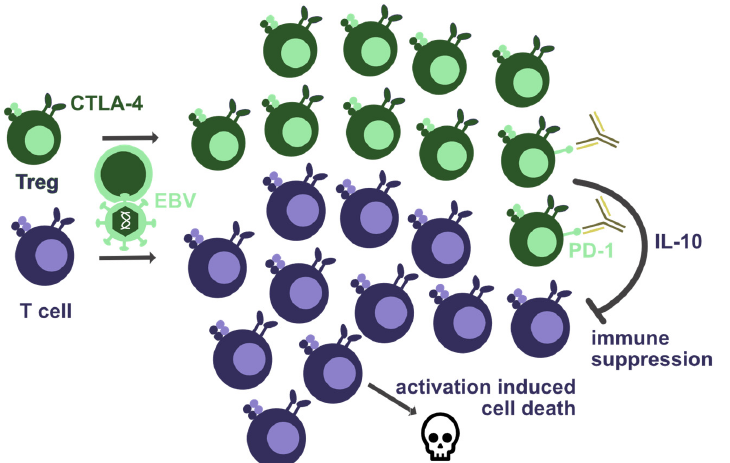
Figure 2. Co-inhibitory receptors that are required for EBV-specific immune control.